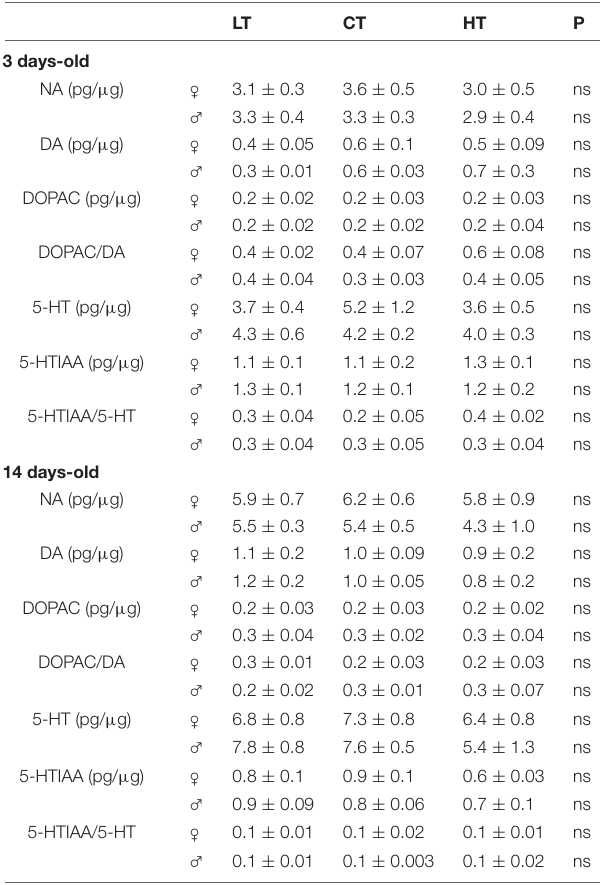
incubation on noradrenaline (NA), dopamine (DA), 3,4-dihydroxyphenylacetic acid (DOPAC), DOPAC/DA, serotonin (5-HT), 5-hydroxyindole-3-acetic acid (5-HIAA), and 5-HTIAA/5-HT in the diencephalon of 3- and 14-days-old female and male